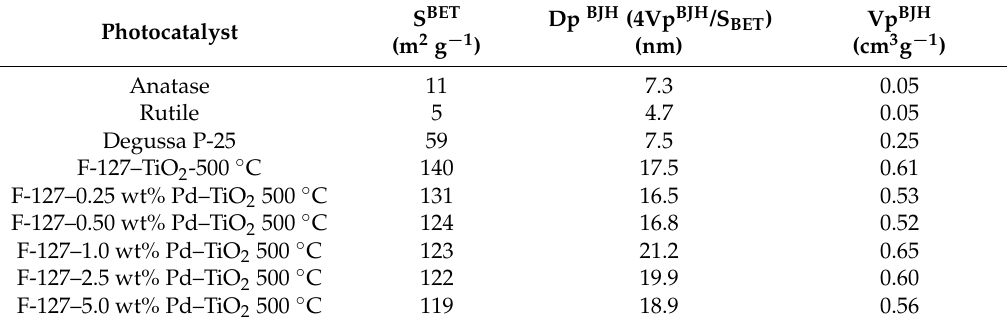
Table 2. Surface area and pore diameter using palladium.